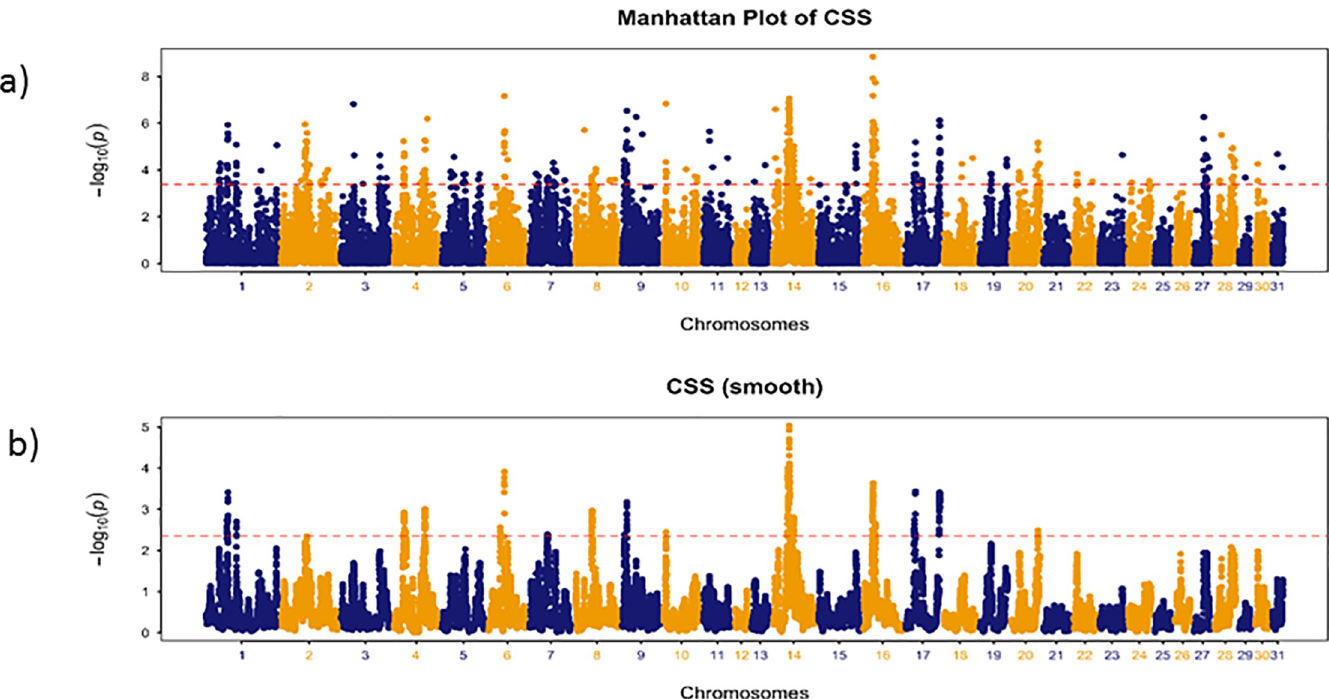
Fig 1. Manhattan plots of CSS and CSS (smooth) results for the Australian versus non-Australian identification of selection signals for Australian the racing phenotype. The strongest signal was on ECA14 at a 5Mb (32.17–37.8 Mb) locus containing 51 genes including multiple protocadherin genes. The highest ranked SNP was closest to the PCDHB15 gene.